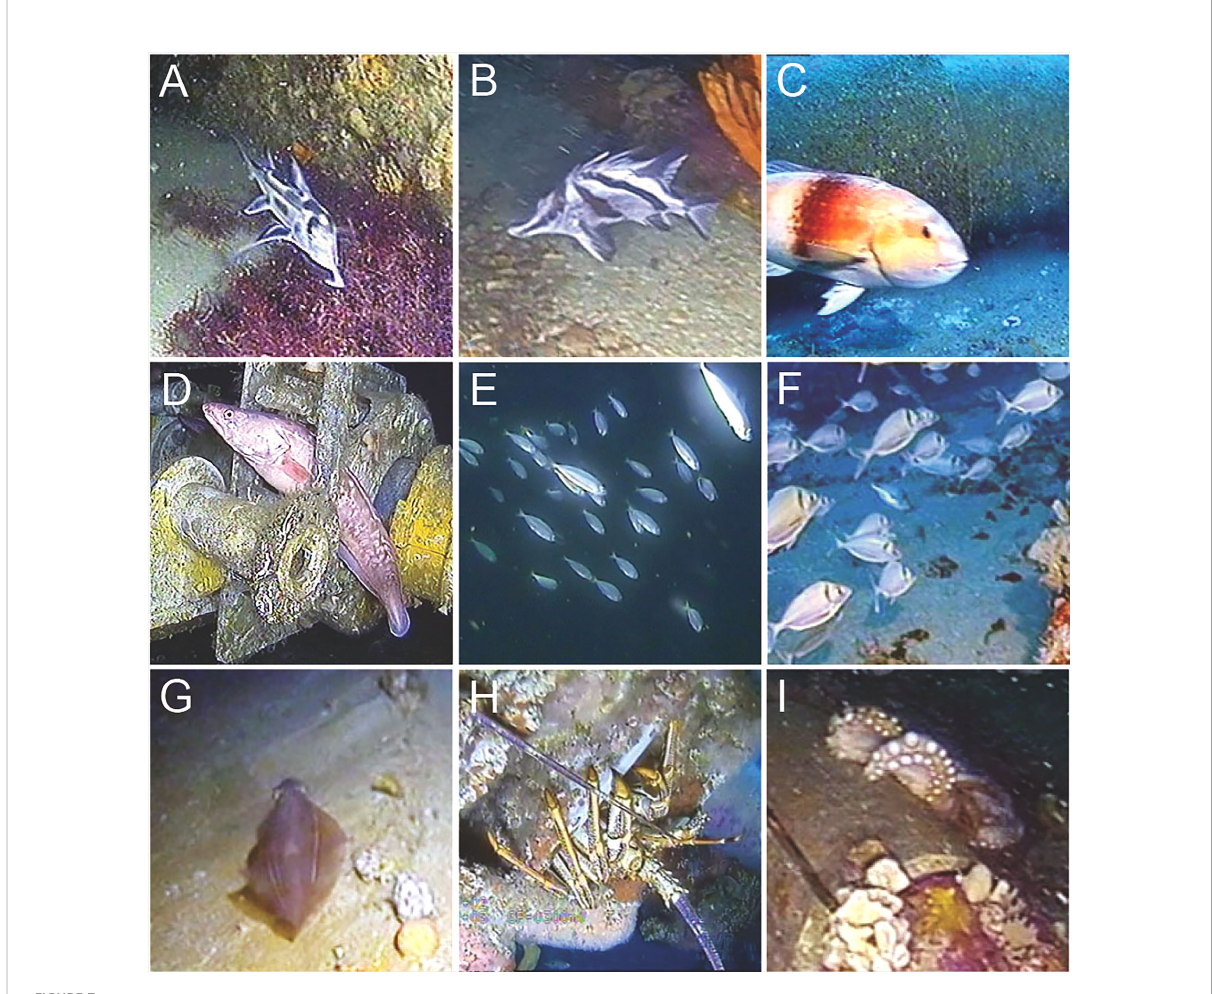
FIGURE 7 Examples of fi shery species observed during industry-collected ROV surveys: (A) elephant fi sh, Callorhinchus milii , (B) longsnout boar fi sh, Pentaceropsis recurvirostris (C) bluethroat wrasse, Notolabrus tetricus , (D) pink ling, Genypterus blacodes , (E) jack mackerels, Trachurus spp., (F) jackass morwong, Nemadactylus macropterus , (G) squid, (H) southern rock lobster, Jasus edwardsii , and (I) an